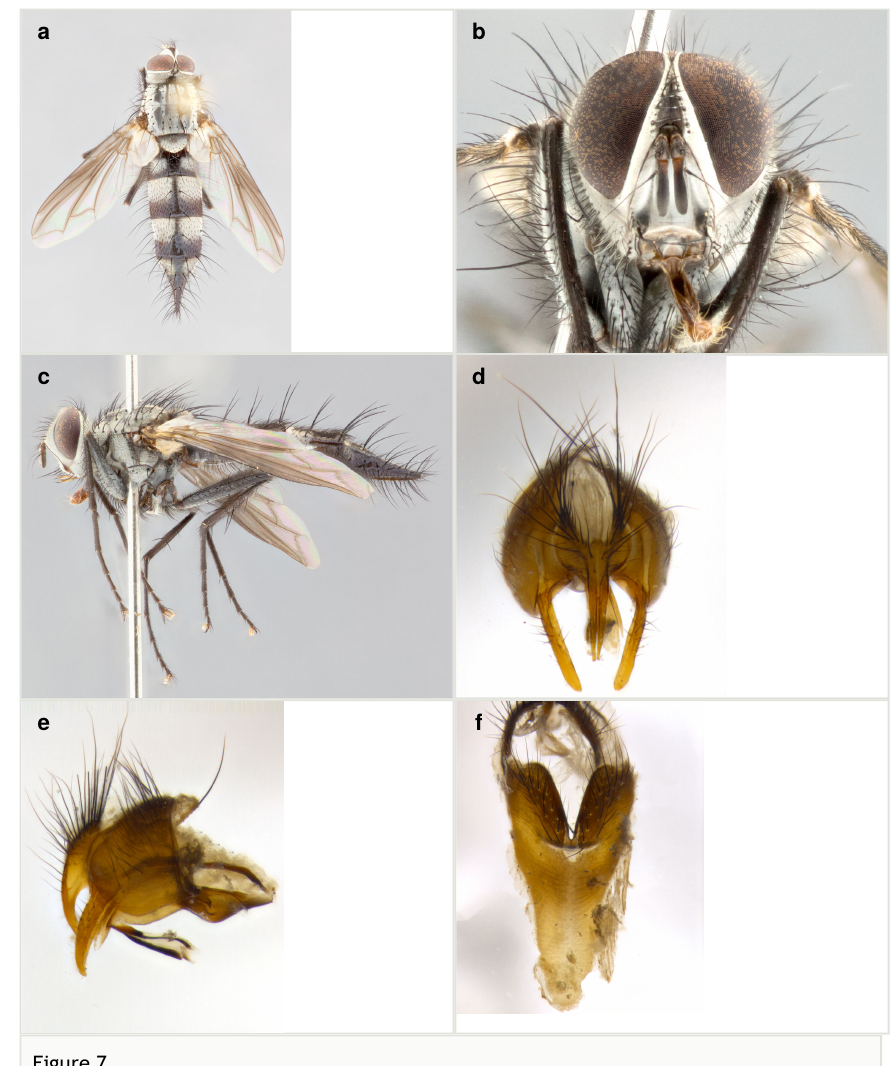
Uramya contraria sp. nov. ; a-c : holotype male; voucher n. DHJPAR0022003; d-f : paratype male; voucher n.